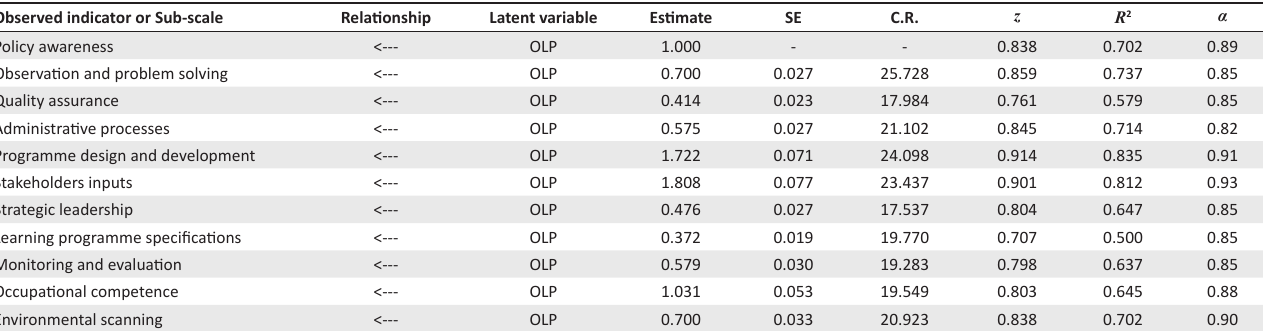
TABLE 2: Regression weights, squared multiple correlations and Cronbach’s alpha. Observed indicator or